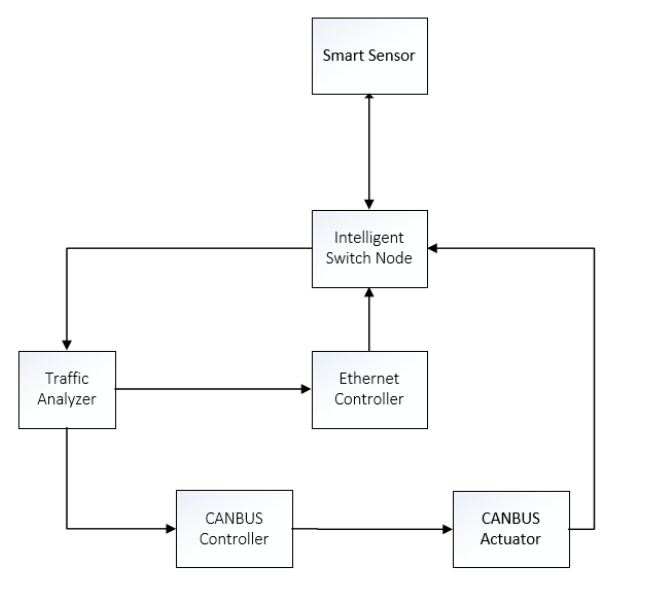
Figure 3. Component